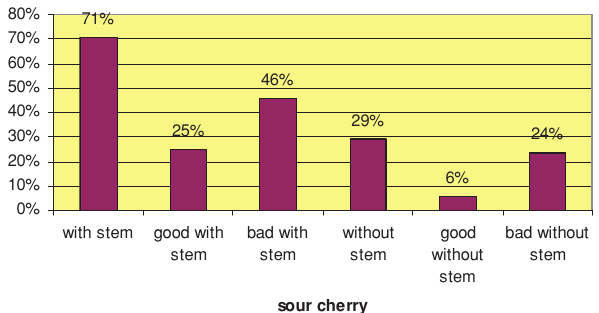
Figure 2. according to the same categories as in Figure 1. 25% was of good quality, 46% of bad quality. The 6% of